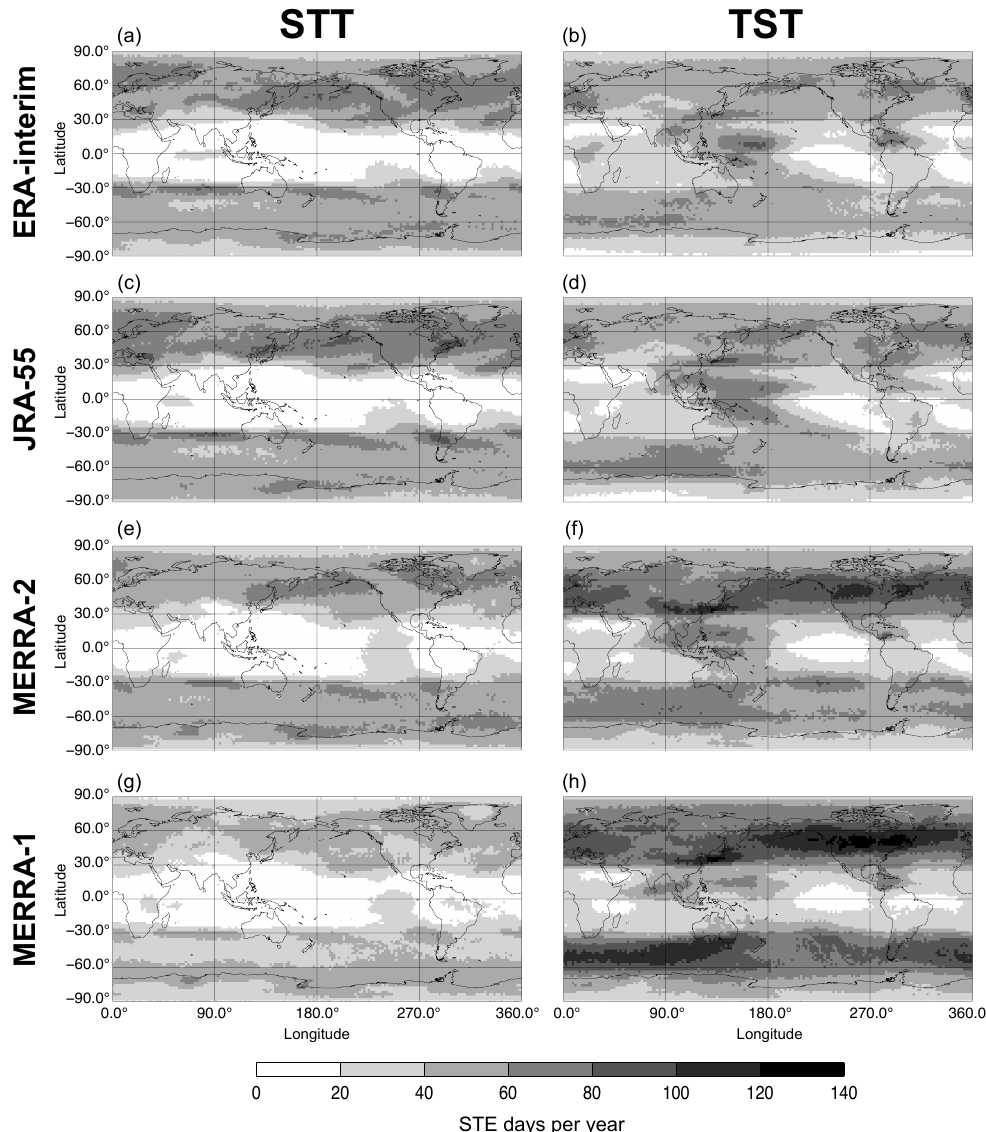
Figure 15. Global occurrence frequency distributions of (left) STT and (right) TST events for (a, b) ERA-Interim, (c, d) JRA-55, (e, f) MERRA-2, and (g, h)